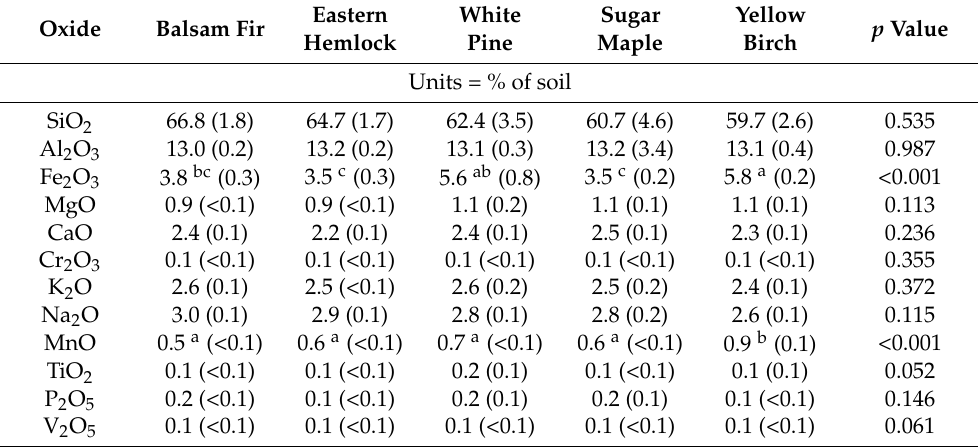
(Table 3). There were no significant differences in base cation oxide proportions (calcium oxide (CaO), magnesium oxide (MgO), and potassium oxide (K 2 O)), and differences were only indicated for iron(III) oxide (Fe 2 O 3 ) and manganese(II) oxide (MnO) which were highest in maple and pine stands. Table 3. Total oxides present in mineral soils (Bm and C horizons) within the five stand types (mean ± S.E.). Different letters represent significant differences among stands. For all stands, n =